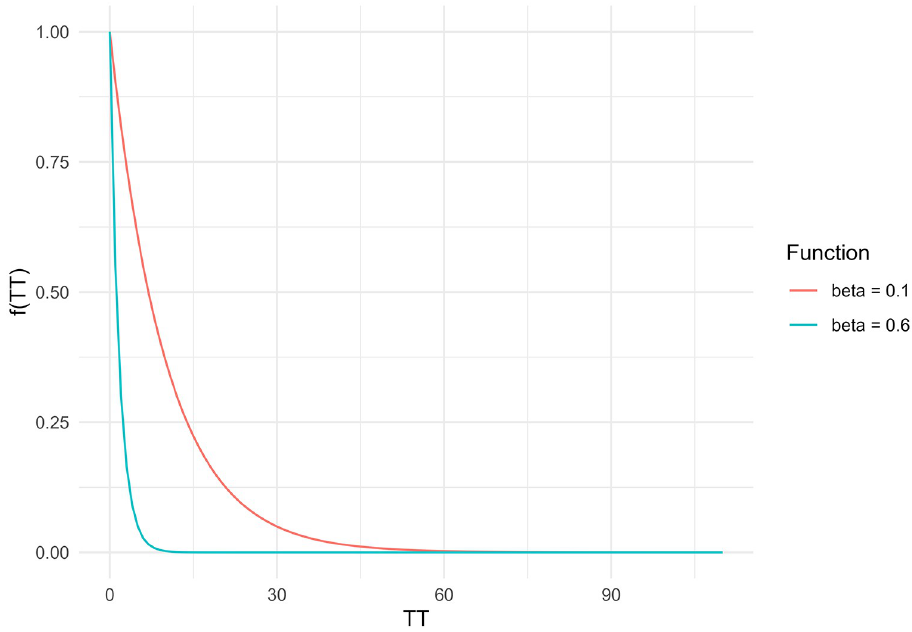
Fig 1. Comparison of two negative exponential impedance functions used in the synthetic example. The x-axis represents the travel time (in mins) and the y-axis represents the impedance function at each travel time.